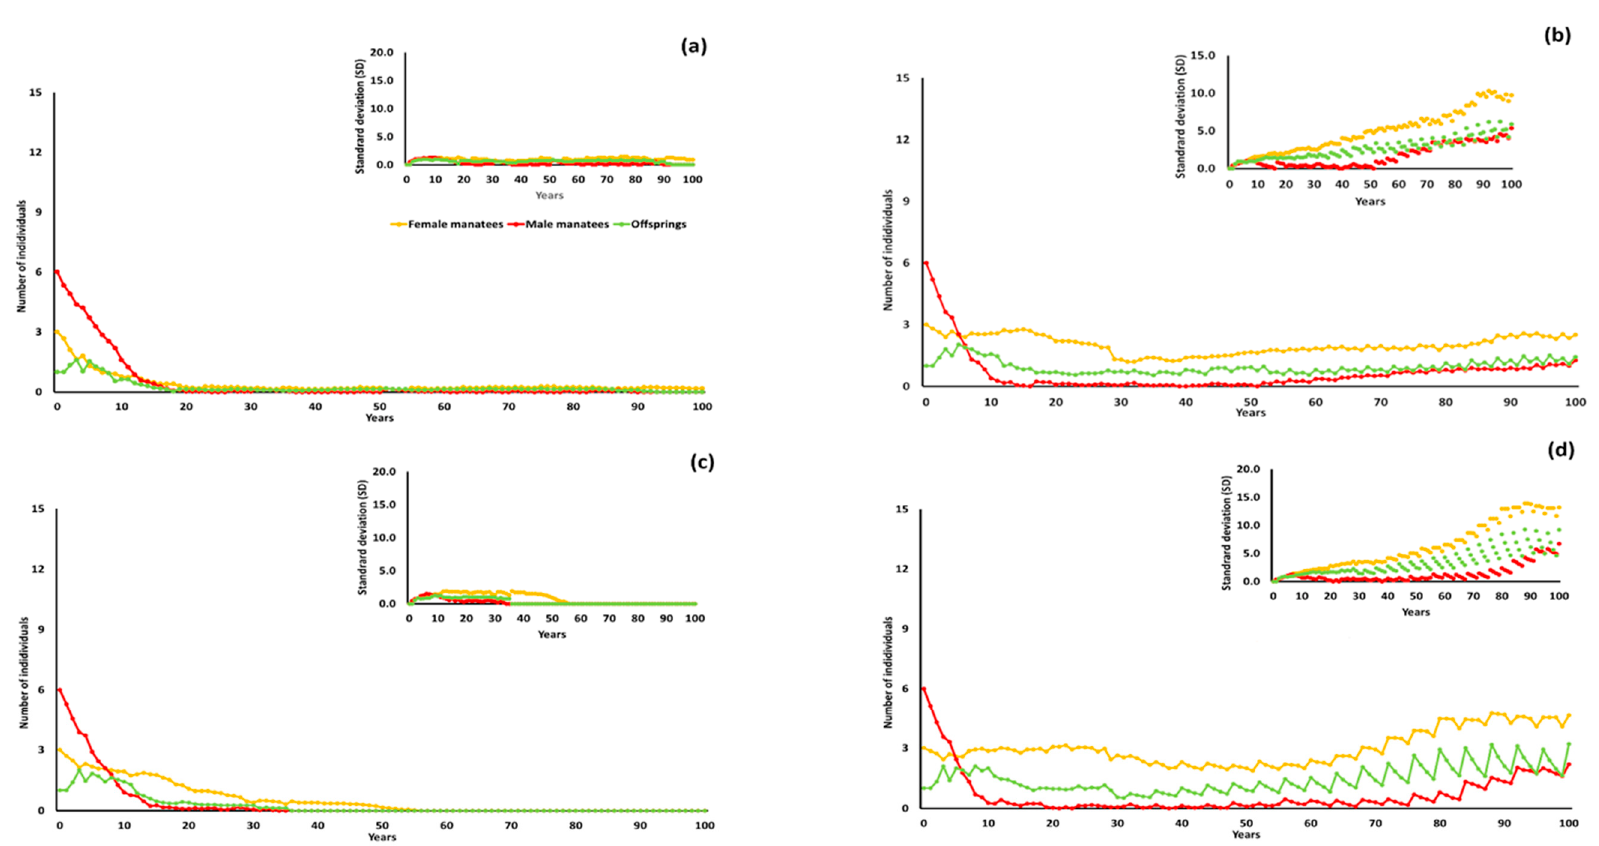
Figure 7. The results from different scenarios to evaluate the long-term viability of the population. ( a ) Scenario favoring gene flow with no conservation activities (Scenario A); ( b ) only conservation activities were in place (Scenario B); ( c ) gene flow (Scenario C); ( d ) gene flow in combination with conservation activities.